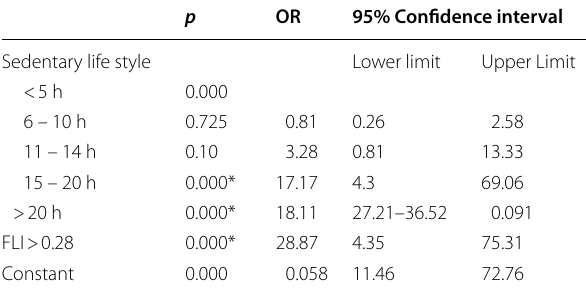
Table 4 Effect of FLI, Polymorphism of rs9939609 FTO Genes and A Confounding Factor on